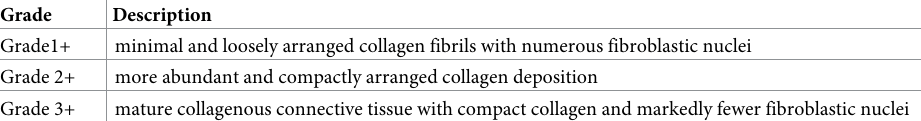
Table 3. Grade of fibroblastic activity in the adhesion (Masson’s